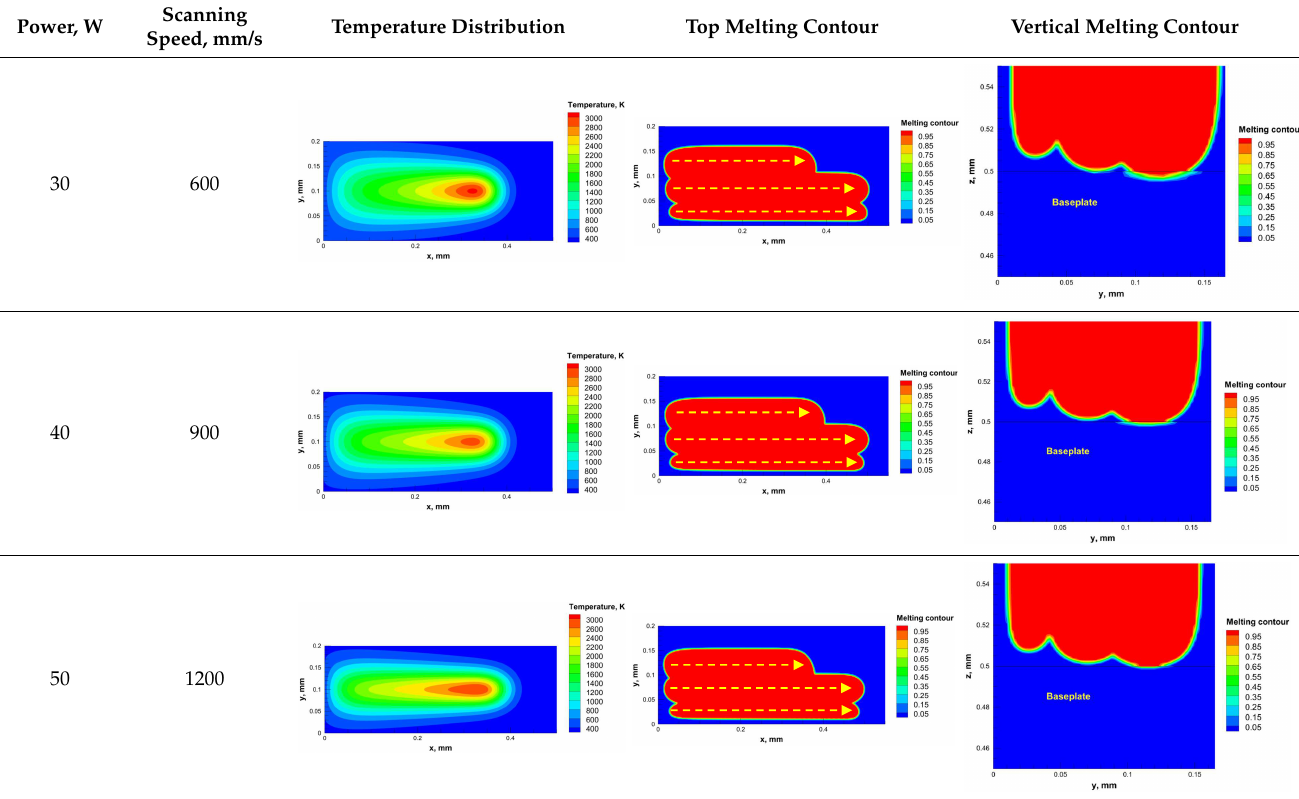
Table 6 . Temperature distribution and melting contour obtained from the numerical model.